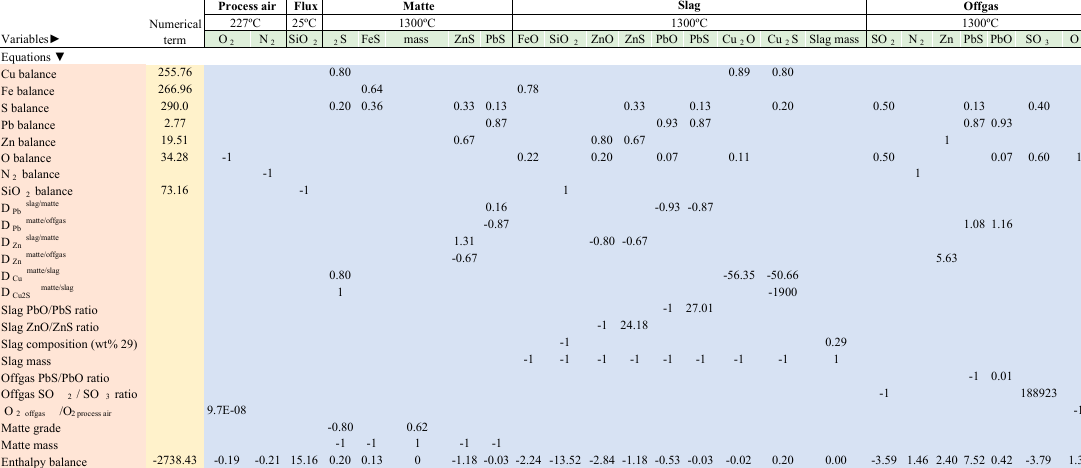
Figure 2. Calculation matrix for the mass and energy balance of the copper smelting process (example for blend 1). At the top, the unknown-variables (greenish) to solve the model balance is consigned. The list of all the balance equations (mass, distribution coefficients, molecular ratios, and enthalpy) is in the left column (brownish). The squared matrix (bluish) collects all the coefficients for each balance equation. The numerical term column (yellowish) collects all the numerical terms for each balance equation. All non-specified terms in the matrix and the numerical terms column are zero. Temperatures are referred to as the thermal conditions of each phase. The temperature of concentrates and blends is 25 °C.